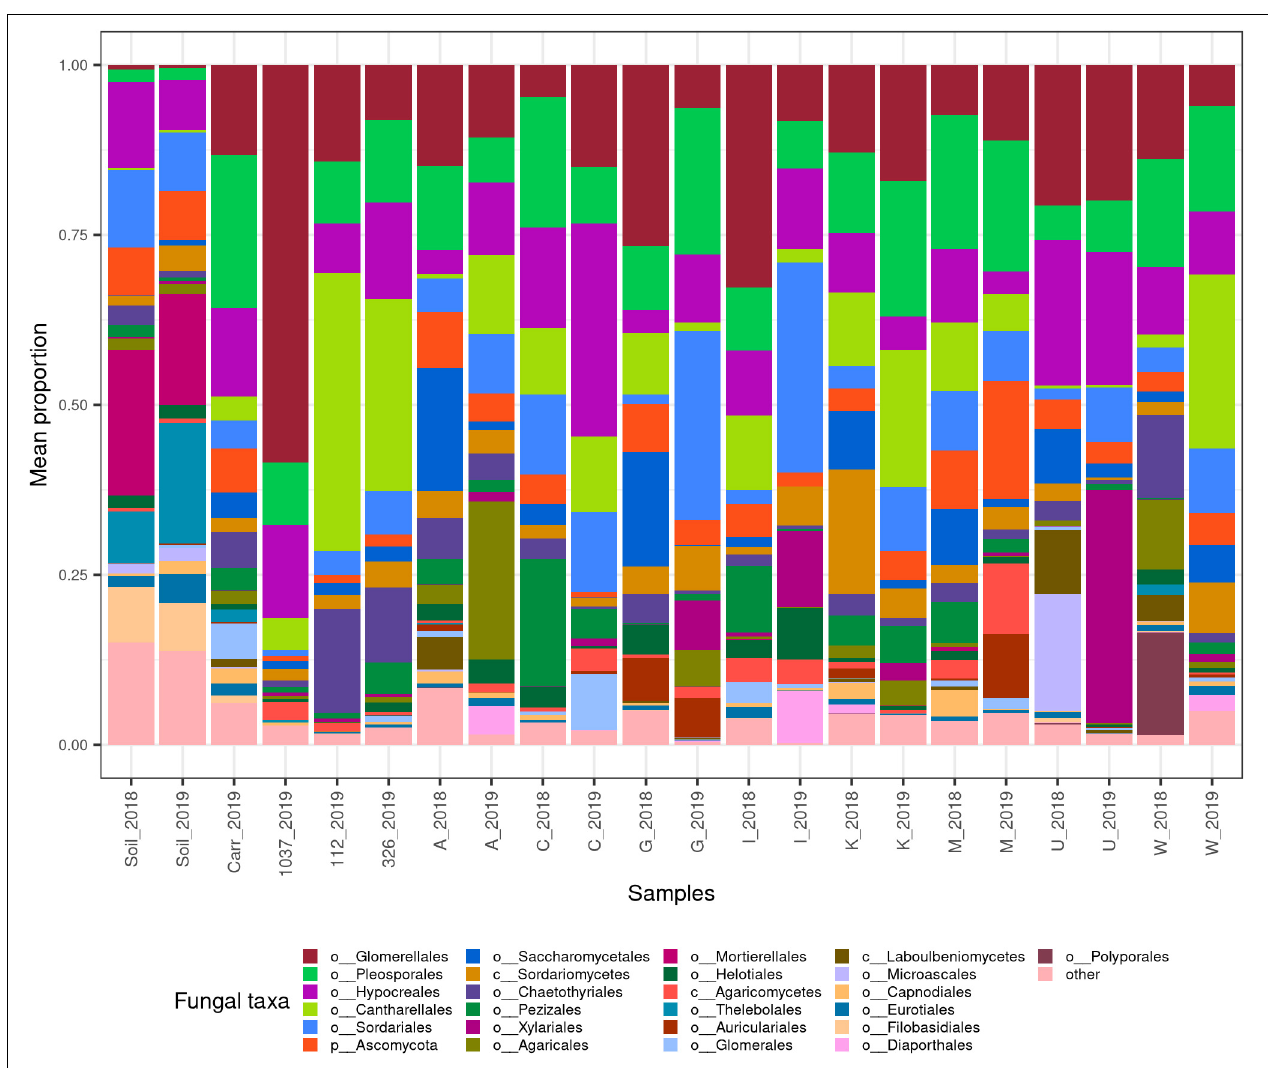
FIGURE 1 | Bar plot showing relative mean proportion of fungal taxa in the endophytic fungal community in all sample groups ( n = 4 per group). The top 25% of filtered, fungal reads are included and aggregated at order level (if not available, the lowest possible taxonomic level). Fungal taxa prefixes follow UNITE